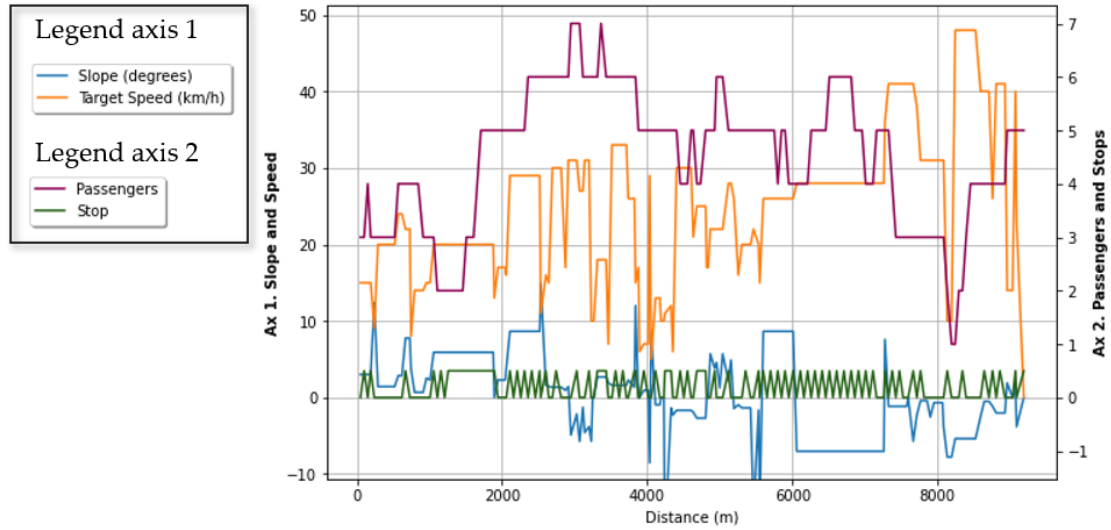
Figure 6. Route plot for an entire bus route on a hillside city.